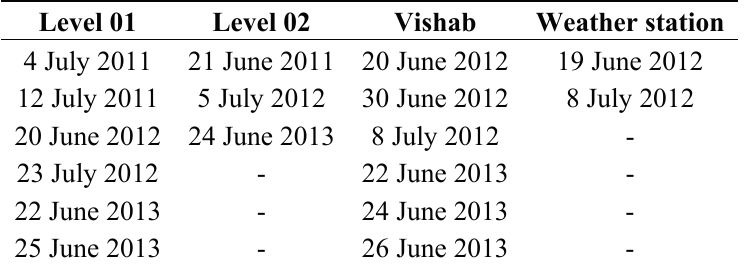
Table 1. Dates of snow field perimeter